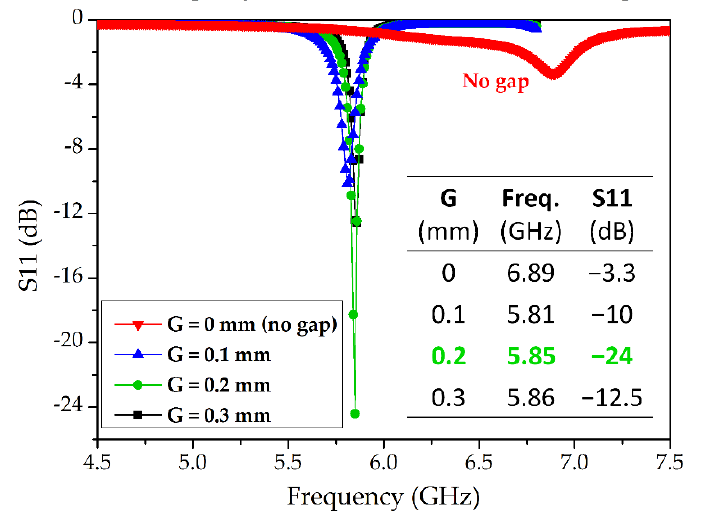
Figure 2. Return loss and notch frequency variation for various coupling gaps (G) between the microstrip line and the TM 02 -mode QMSIW triangular patch. The coupling gap of G = 0.2 mm yields the best impedance matching before the loading of the microfluidic channels. The largest notch frequency variation is 40 MHz while G changes from 0.1 mm to 0.2 mm.